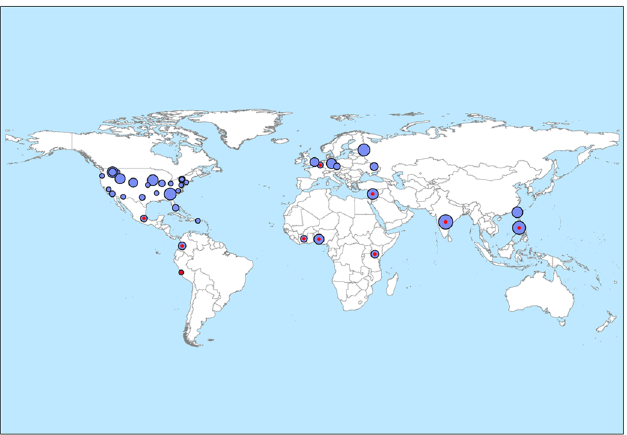
Fig 1. Global distribution of Indian-origin germplasm conserved by national and international genebanks. The radius of each circle is relative to the number of Indian-origin accessions conserved, and the circle sizes were partitioned into 10 size classes. Circles with red indicator represent the CG genebanks.